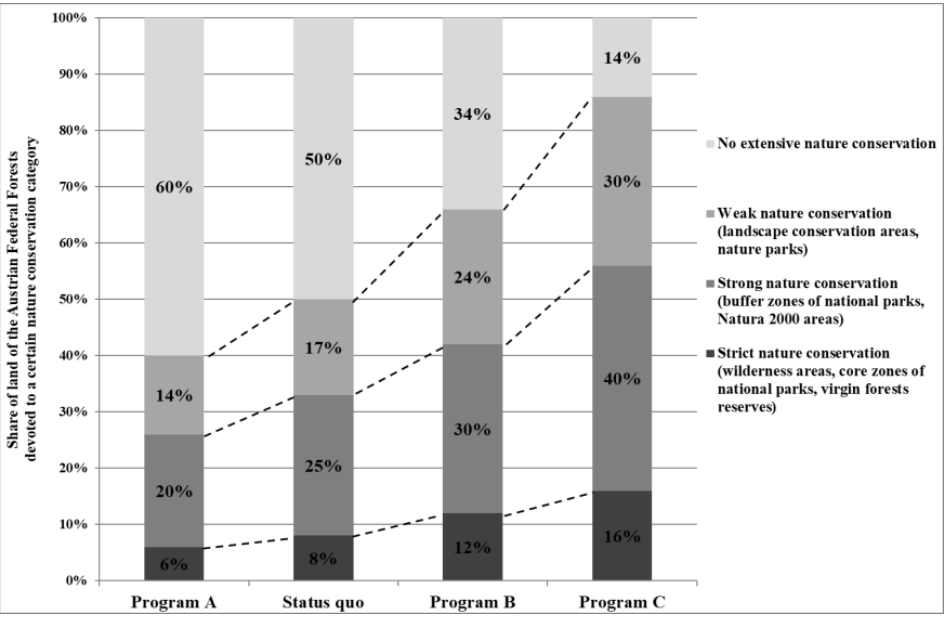
Figure 2. Presentation of the programs in the survey.